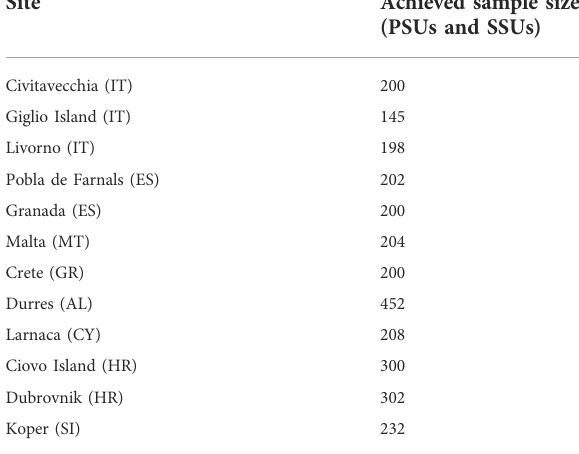
TABLE 1 Sample sizes by site.